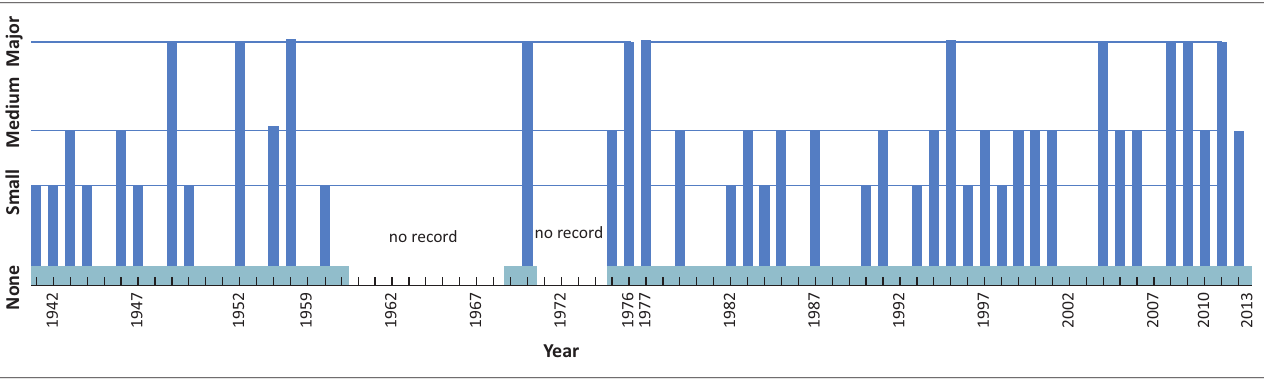
FIGURE 4: Flood levels from year-to-year in the CRB, northern